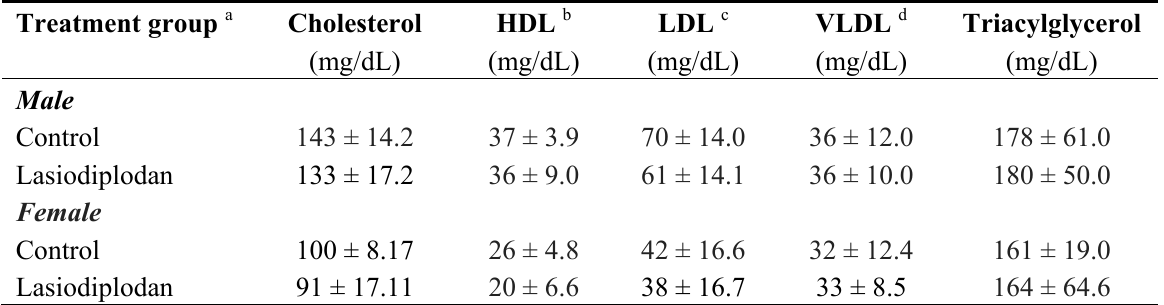
Table 1. Blood lipid profile of male and female mice groups after a 28-day treatment with lasiodiplodan by gavage.